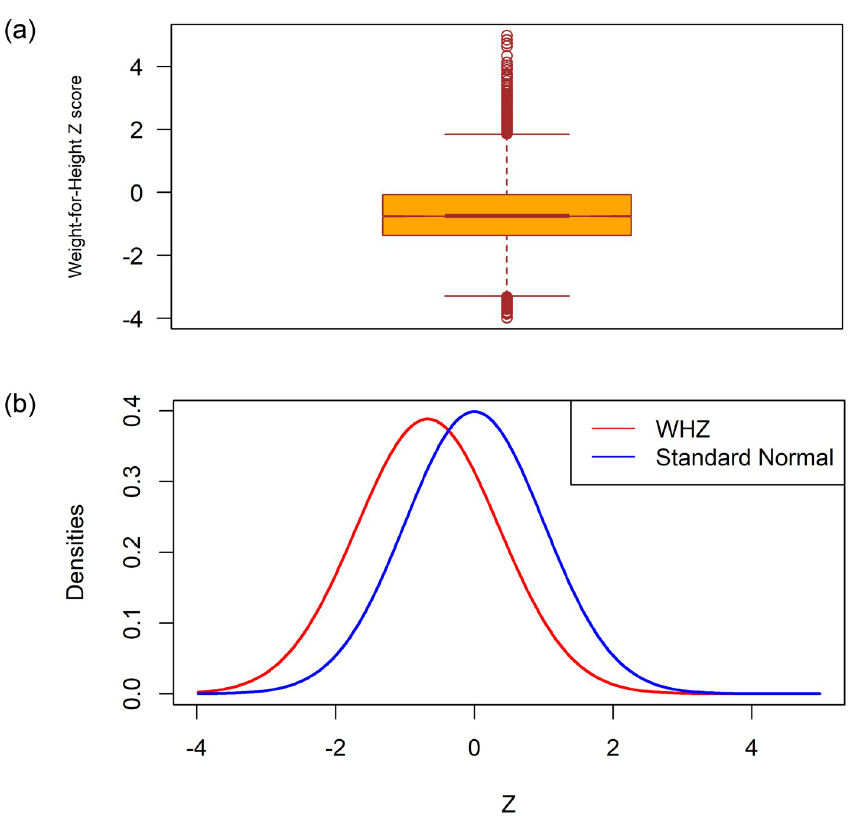
Fig 1. Box and density plot of the weight-for-height (WHZ) Z-scores with the standard normal